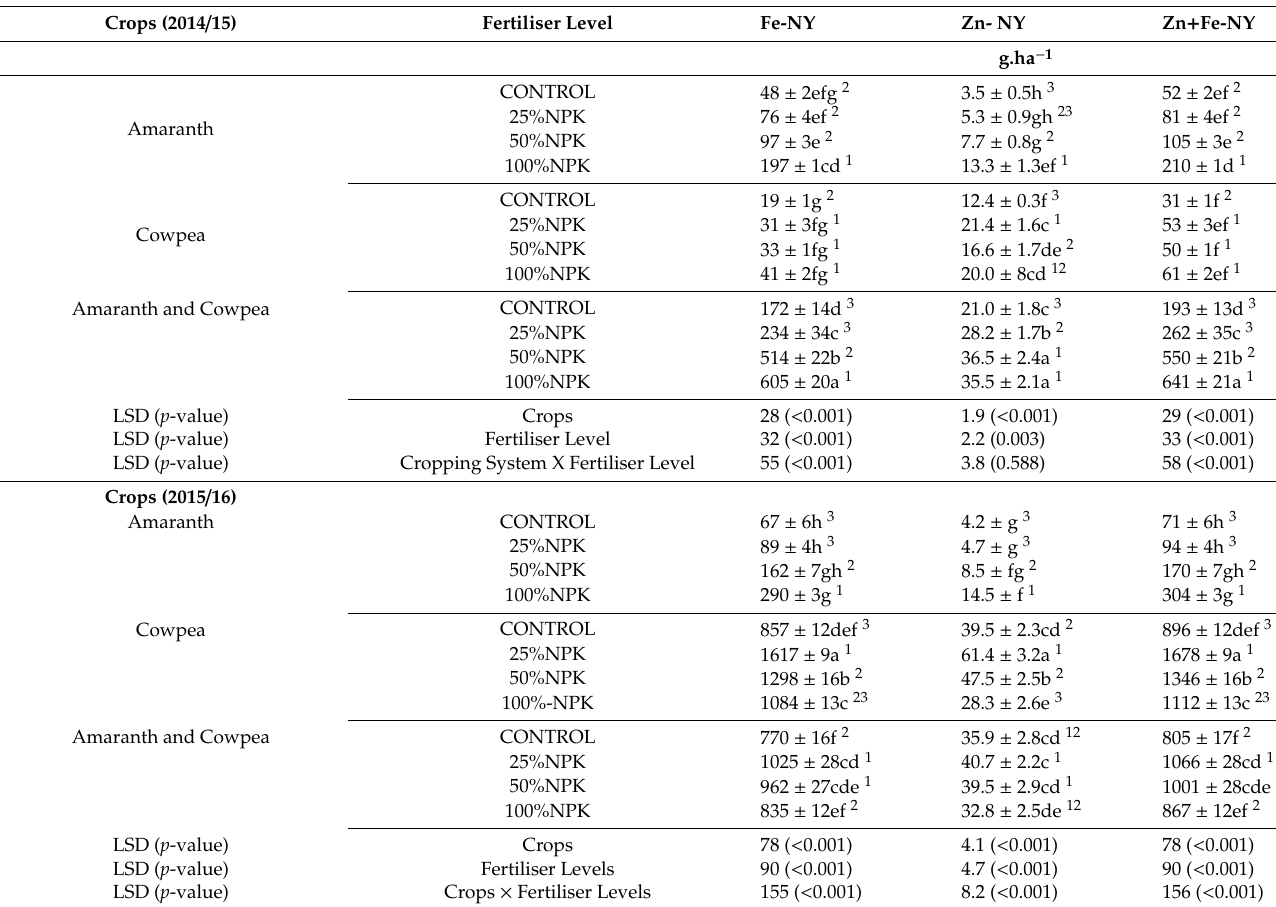
Table 5. Iron nutritional yield (Fe-NY), Zinc nutritional yield (Zn-NY) and combined zinc and iron nutritional yield (Fe + Zn-NY) of cowpea and amaranth under sole and inter-cropping systems at four fertiliser (NPK) levels in 2014 / 15 and 2015 / 16 summer